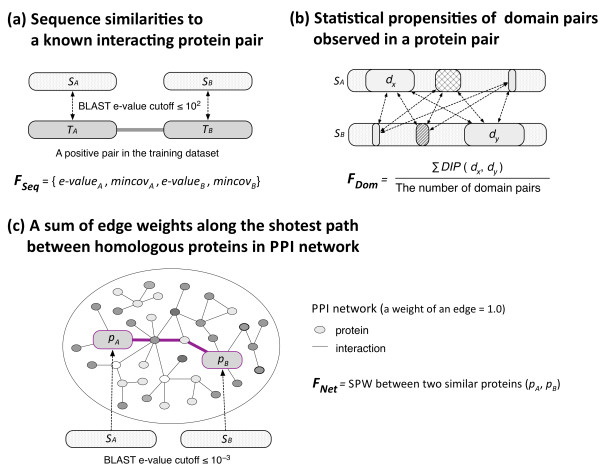
Three homology-based features used for training AODEs. (a) A feature set of sequence similarities to known interacting proteins (FSeq = {e-valueA, mincovA, e-valueB, mincovB}). For a target pair (SA, SB), the interacting pair (TA, TB) with the smallest value of √(e-valueA2 + e-valueB2), where e-valuex is a BLAST e-value between Sx and Tx and x is either A or B, is selected, and then the minimum coverage (mincov) for Sx and Tx is calculated as (the number of positive matches)/(the length of the longer sequence). If no known homologous interacting pair is found, an e-value of 102 and a mincov of 0 are assigned to FSeq. (b) Statistical propensities of domain pairs observed in interacting proteins (FDom). A sum of the interaction propensities for all possible Pfam domain pairs (dA, dB) appeared in Sx and Tx is calculated (see more details in the text). If not Pfam domain is found, an FDom value of 0 is given to the target pair. (c) A sum of edge weights along the shortest path between homologous proteins (PA, PB) in the PPI network (FNet). In this study, we set the default edge weight to be 1.0. If no path is found, an FNet of -1 is given to the target pair.